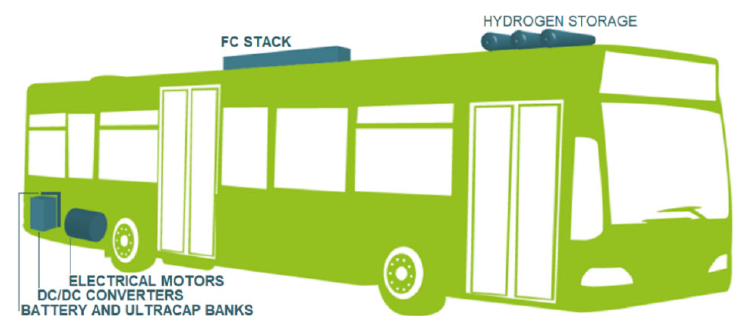
Figure 6. General design of an FCEB.